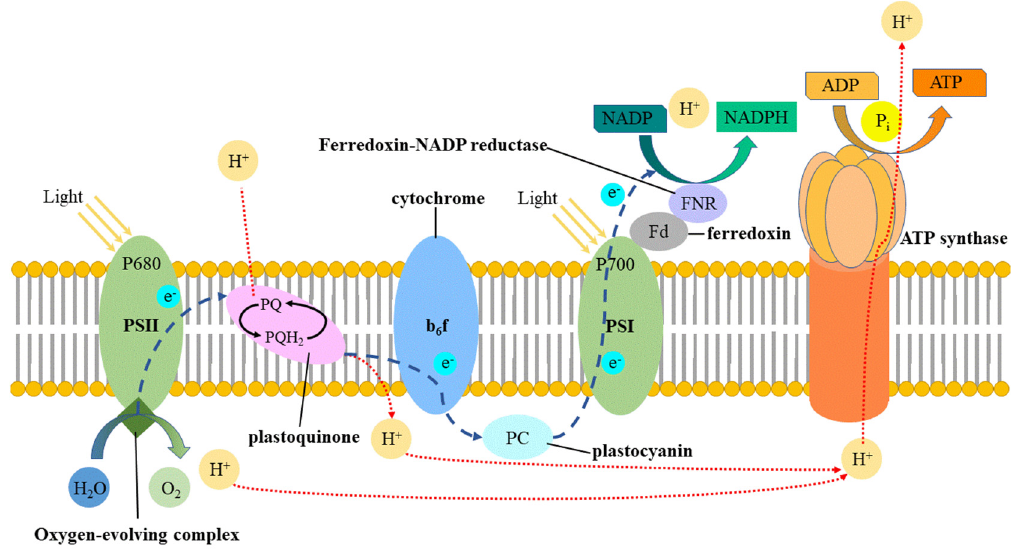
Figure 8. Schematic diagram of the light system participating in plant growth [58] .